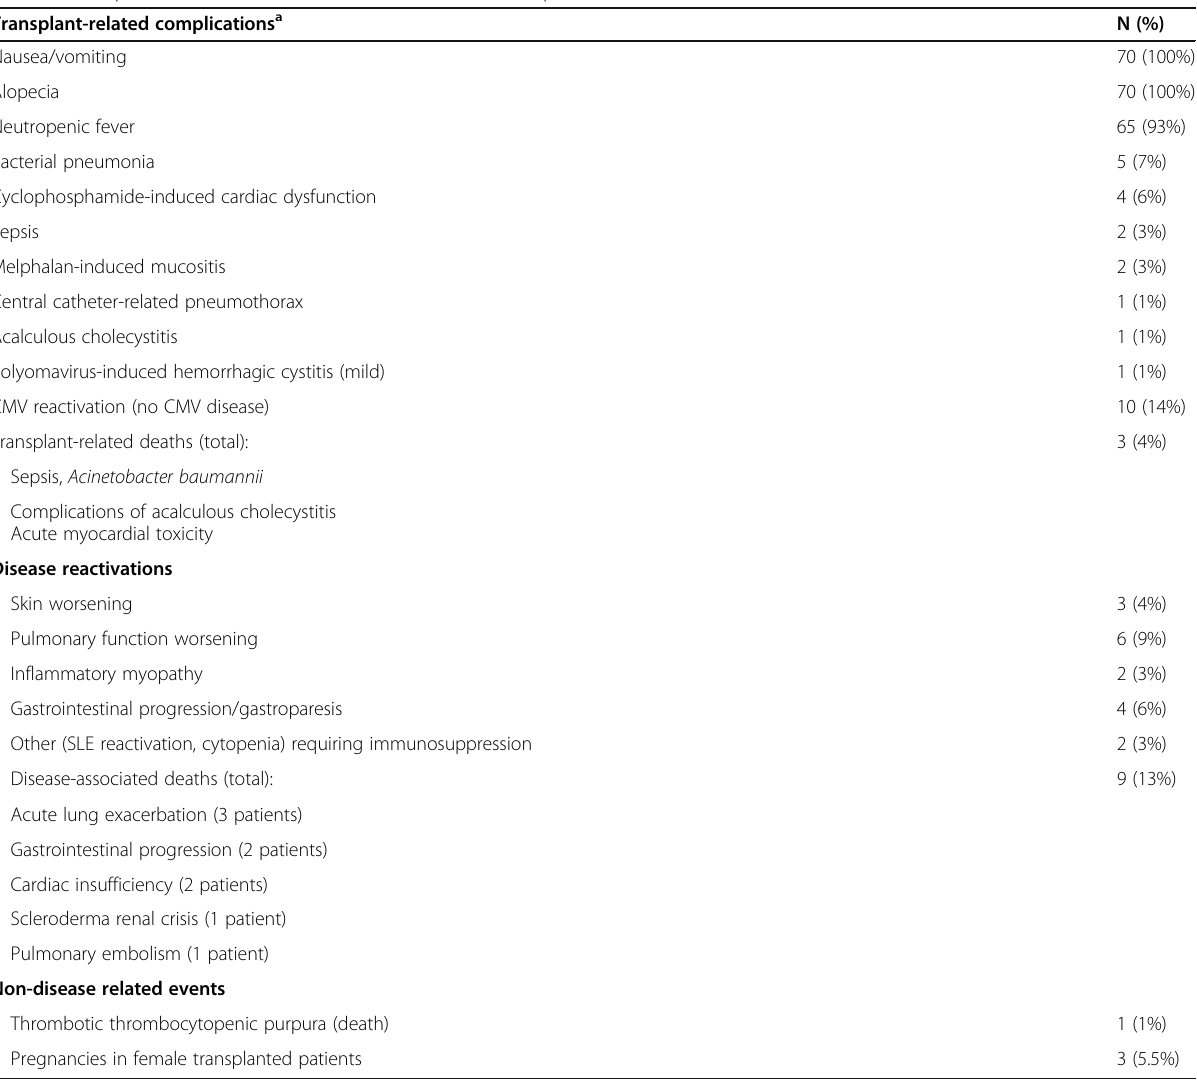
Table 2 Complications and disease-related events after transplantation Transplant-related complications